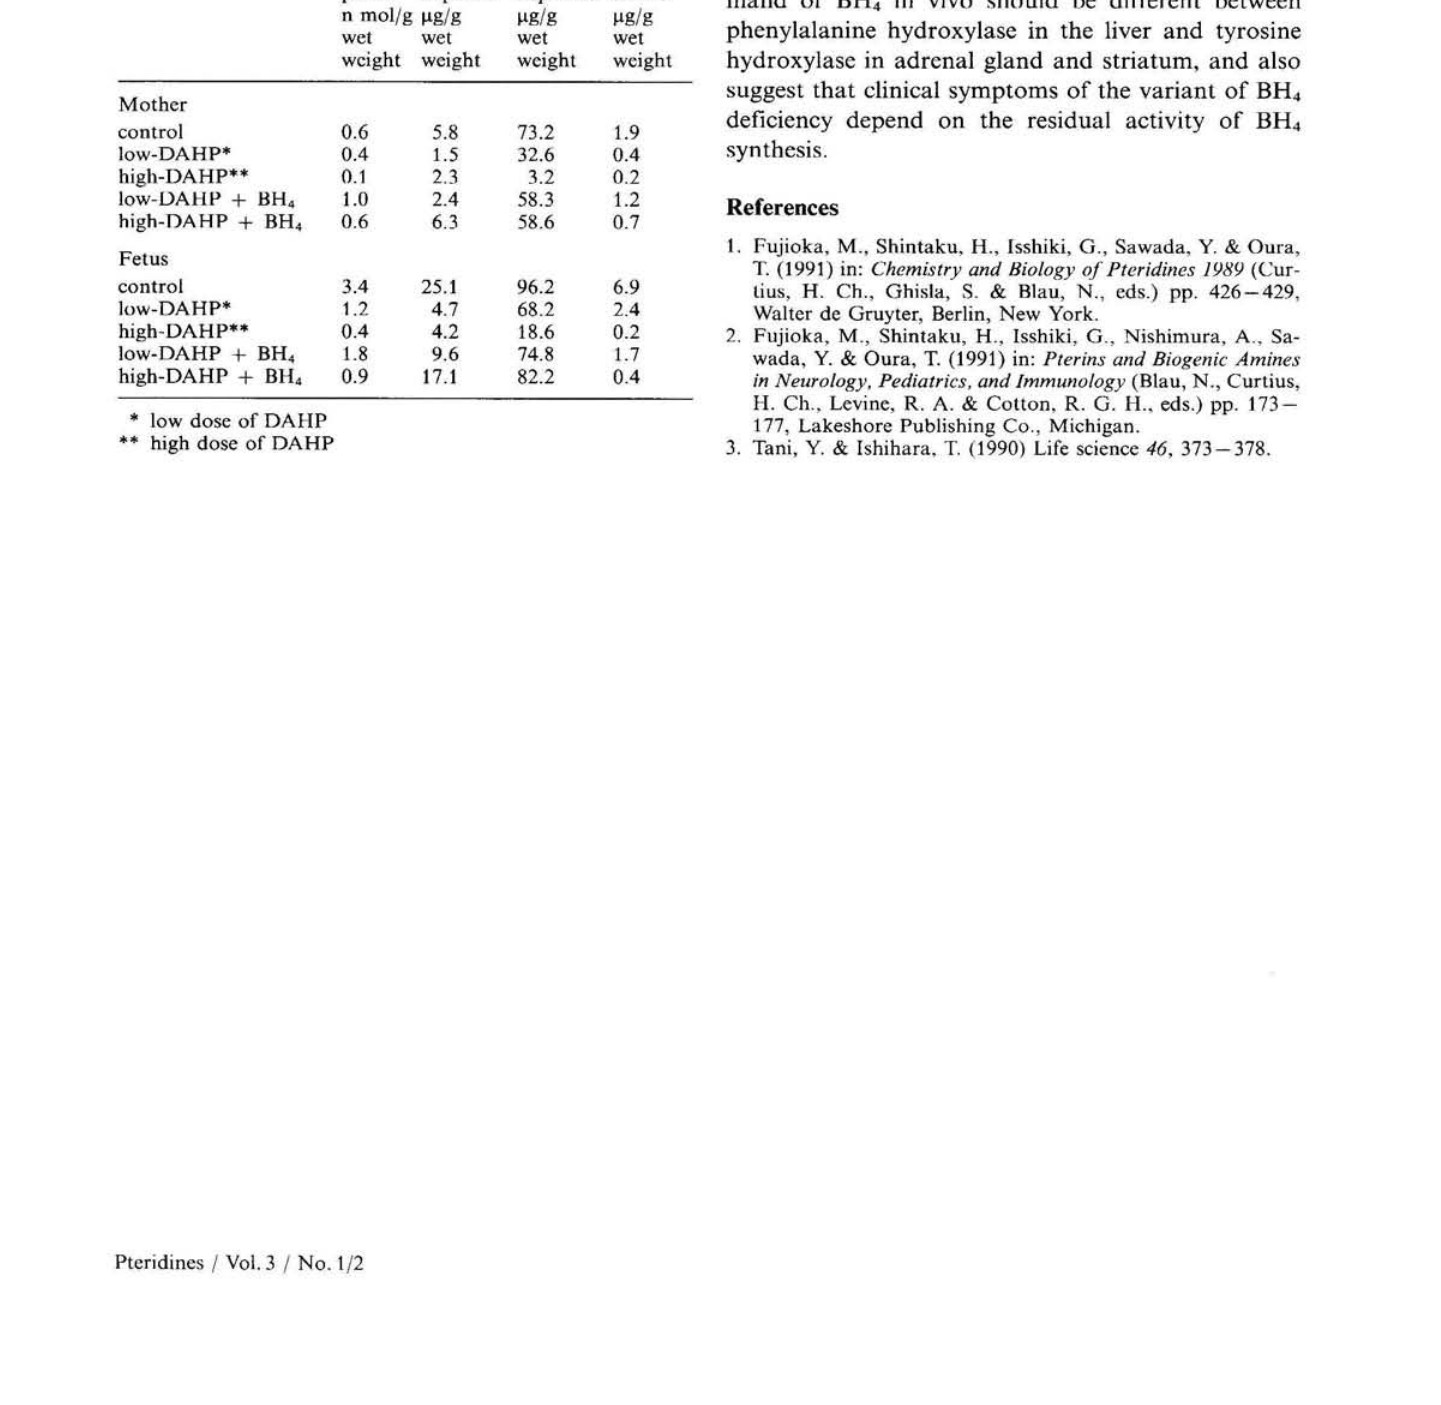
Table 2. Biopterin, norepinephrine, epinephrine and dopamine levels in adrenal gland. Bio- Norepi- Epi- Dop- pterin nephrine nephrine amine η mol/g μg/g μg/g μg/g wet wet wet wet weight weight weight